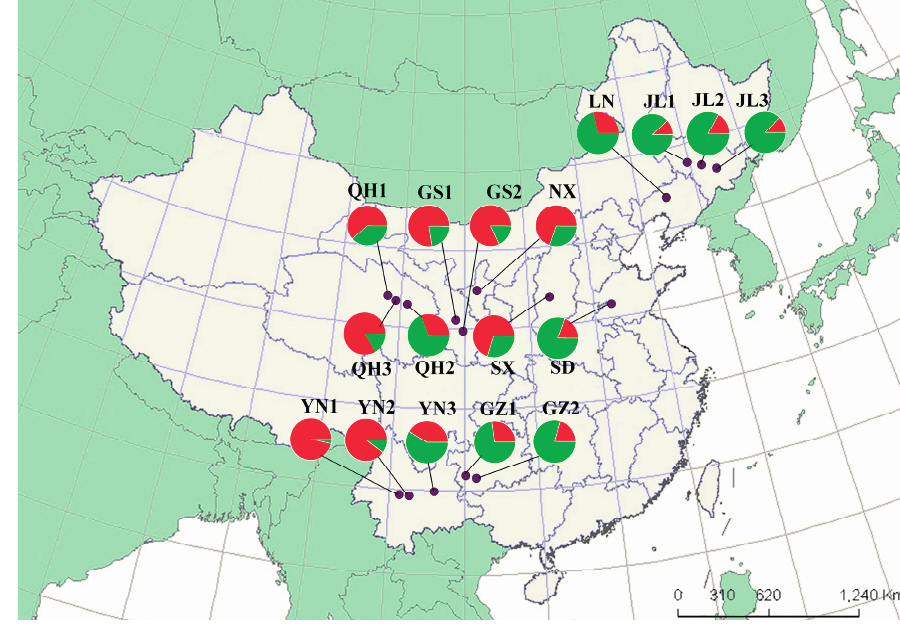
listed in Table 1. QH1, QH2, and QH3 represent three populations from Qinghai. GS1 and GS2 represent two populations from Gansu. YN1, YN2, and YN3 represent three populations from Yunnan. GZ1 and GZ2 represent two populations from Guizhou. JL1, JL2 and JL3 represent three populations from Jilin. NX, SX, SD, and LN represent the population from Ningxia, Shanxi, Shandong, and Liaoning,